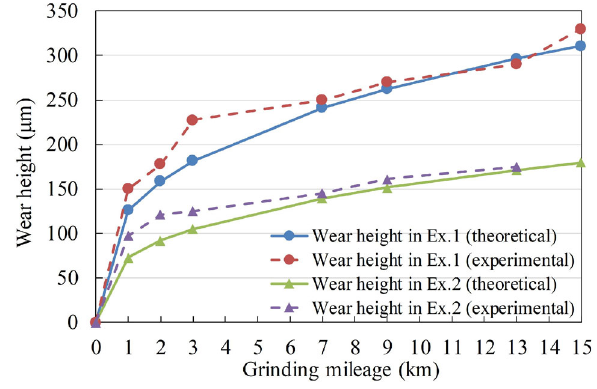
Fig. 13 Abrasive belt wear height versus grinding